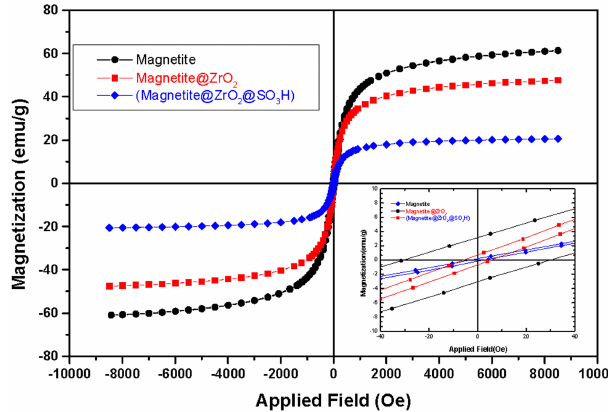
Fig. 6. Magnetization curves for the MNPs, Fe 3 O 4 @ZrO 2 and Fe 3 O 4 @ZrO 2 -SO 3 H at room temperature.